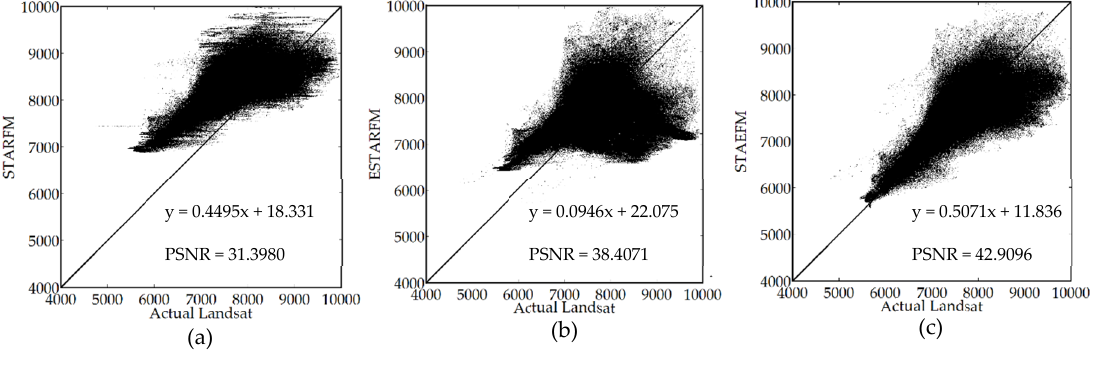
Figure 7. Comparison of Landsat TIR images with fused images of ( a ) STARFM, ( b ) ESTARFM, and ( c ) STAEFM after being normalized from 0 to 10,000.